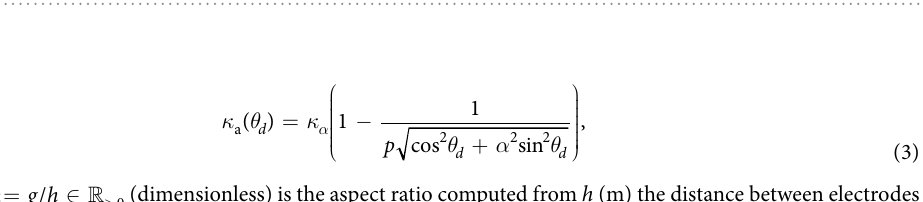
Figure 11. ( A ) Schematic showing the in situ measurement of anisotropic permittivity in D = 2 angles using monopolar needles 14,17 . Current and voltage electrodes are at the same depth, shown in red and blue color, respectively. ( B ) Schematic of the d -th angle measured in the xy -plane ( z = 0). The measurement angle θ d is defined with respect to the muscle fibers’ transverse (T) { x , z } direction φ T (i.e. φ T = θ when θ = 0) and φ L is the longitudinal y direction. Electrode configuration: Id 2 1  − , source current electrode; Vd 2 1  − , high potential electrode;  Vd 2 , low potential electrode; Id 2  , sink current electrode; where = d D 1, 2, ,  and D is the number of different angles measured from 0 to π with θ i + θ j ≠ π